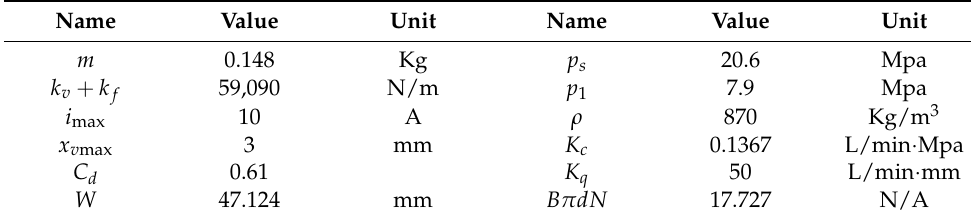
Table 3. Hydraulic system parameters.